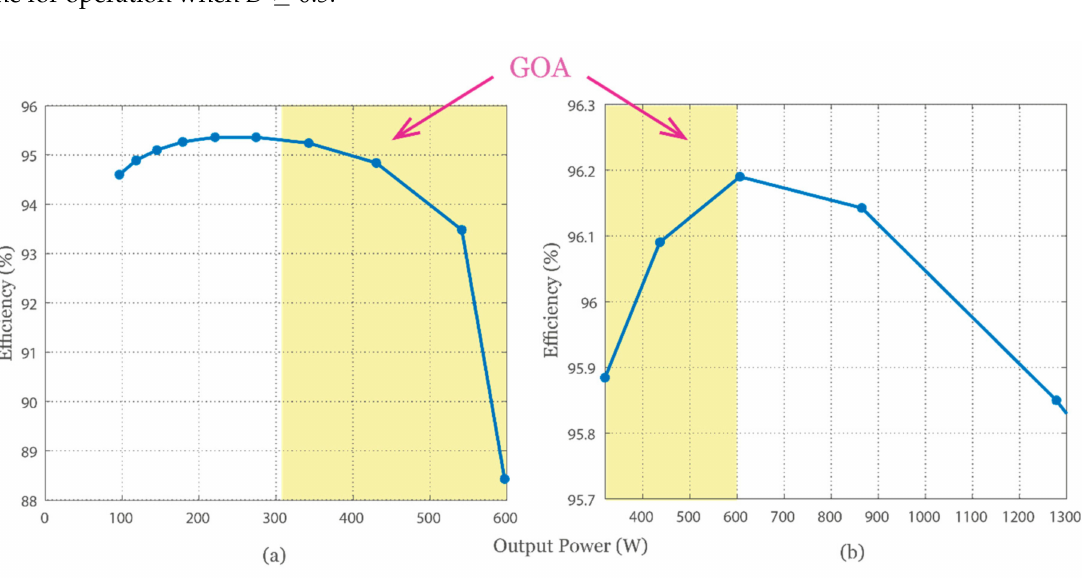
Figure 11. Efficiency curves of the proposed converter ( V in = 100 V, R L = 120 Ω ) ( a ) When D < 0.5. ( b ) When D ≥